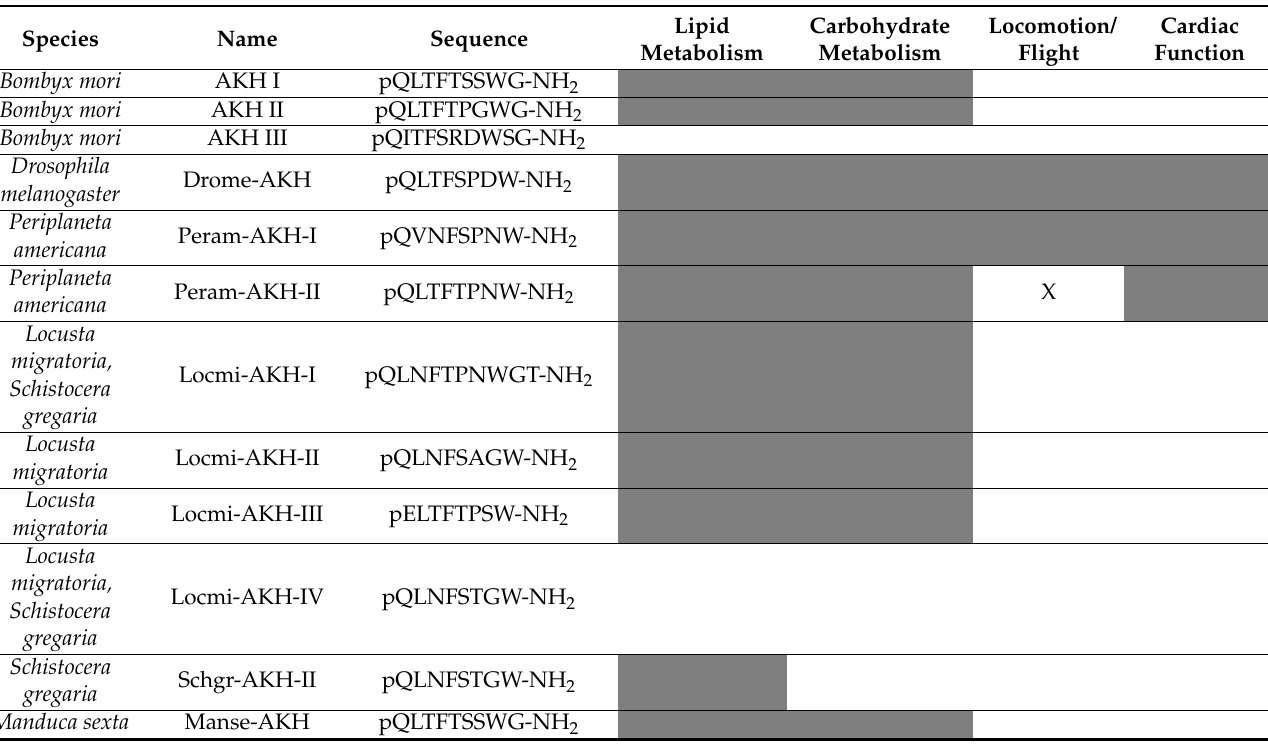
Table 1. AKH isoforms possess conserved function. Examination of the physiological effect of each AKH isoform as reported in six difference species [9,17–20]. In general, it appears that many AKH isoforms are redundant and serve to initiate carbohydrate and lipid metabolism. Filled boxes indicate that the isoform has an effect on a given phenotype, empty boxes indicate a lack of data, and checked box indicates that evidence supports a lack of